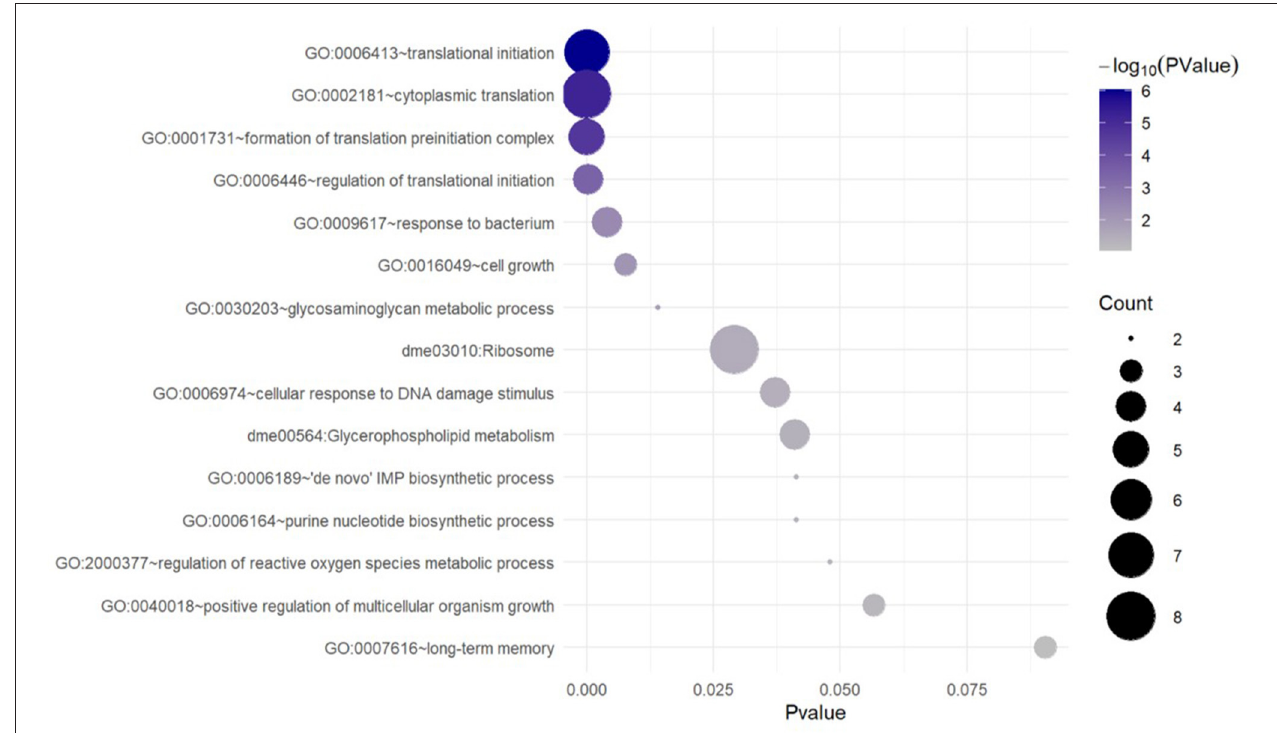
FIGURE 3 | Unique GO and KEGG terms enriched with the genes that are upregulated in response to AMPH in a DAT-dependent manner. Functional category/term names are on the left. Circle sizes are proportional to the number of DE genes (gene counts), which were annotated as belonging to the corresponding functional